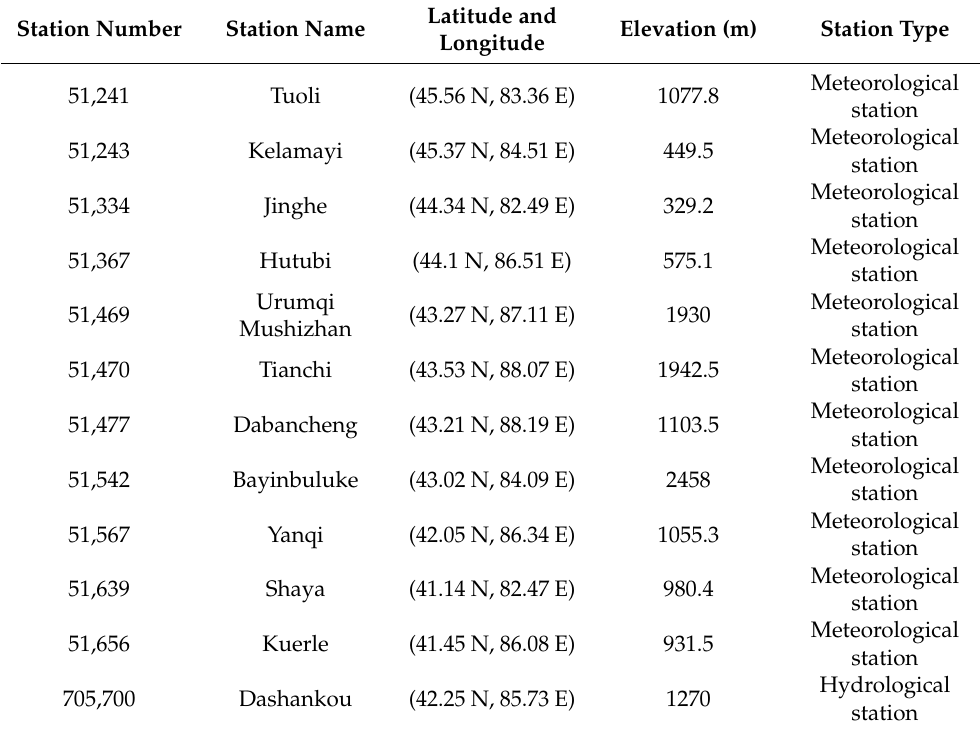
Table 1. The information on the hydrological and meteorological stations in the upper Kaidu River